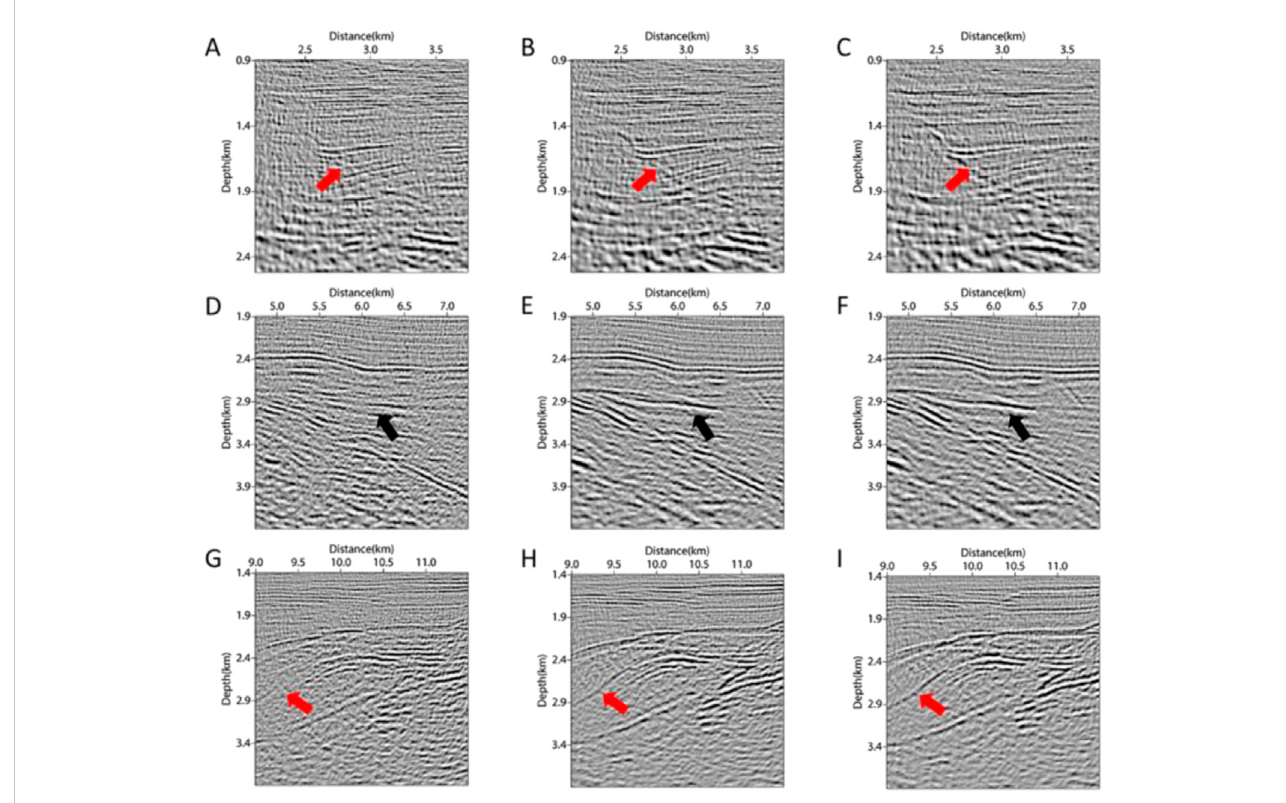
FIGURE 18 Enlarged imaging results corresponding to the red solid line boxes in Figure 17. Migration results of left solid line box using (A) RTM, (B) VTI RTM, (C) VTI PDRTM,respectively;migrationresults ofmiddlesolidlinebox using (D) RTM, (E) VTI RTM, (F) VTIPDRTM,respectively;migrationresultsofrightsolidlinebox